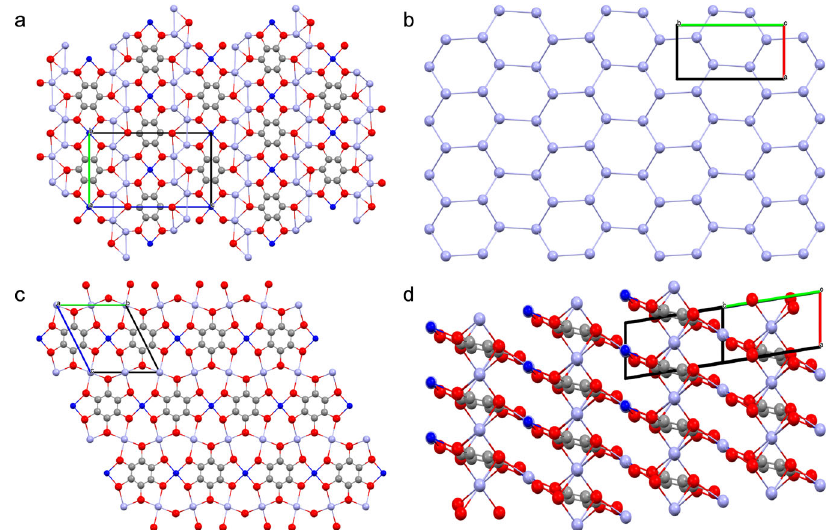
Fig. 3 | Representation of the crystal structures of CuAg x BHTs. a Crystal struc- ture of CuAg 4 BHT viewed along the a -axis direction. b Honeycomb-like lattice formedbyadjacentAgatomsinCuAg 4 BHT(viewedalongthe c -axis). c Topviewof the Kagome-like lattice in CuAg 2 BHT (viewed along the a -axis). d Side view of the